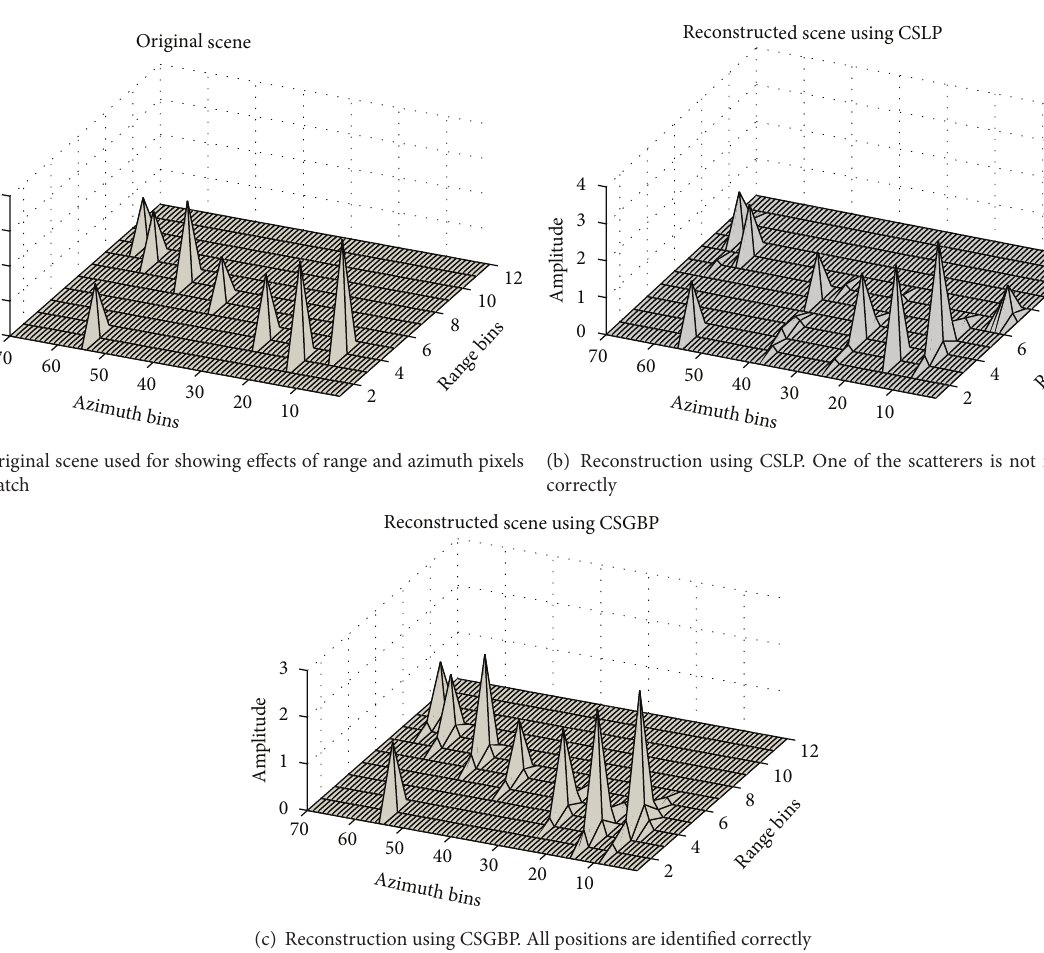
Figure 6: Reconstruction in the presence of range and azimuth pixels mismatch using CSLP and